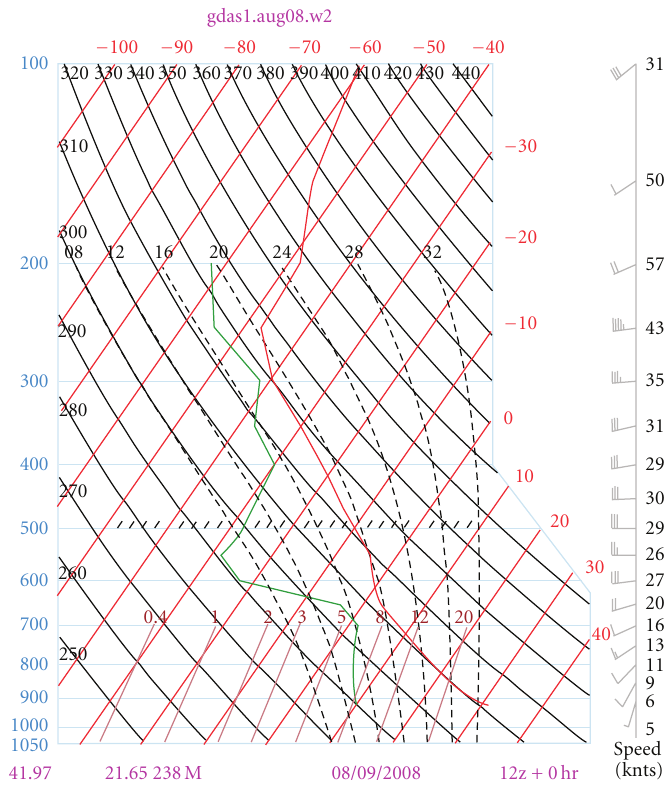
Figure 1: Upper-air sounding for Skopje, Macedonia on the 9th August, 2008 12